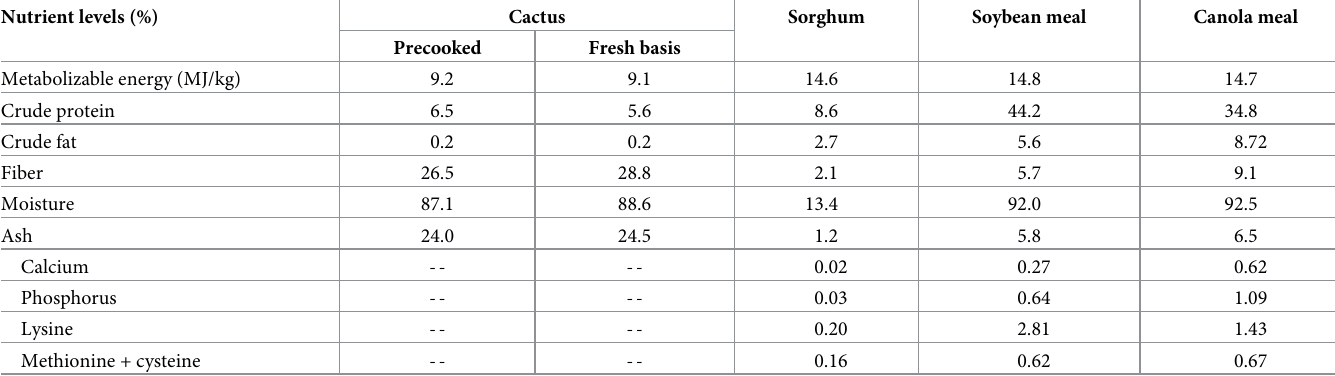
Table 2. Analyzed values for cactus ( O . ficus-indica ) and major nutrients used in diets. Nutrient levels